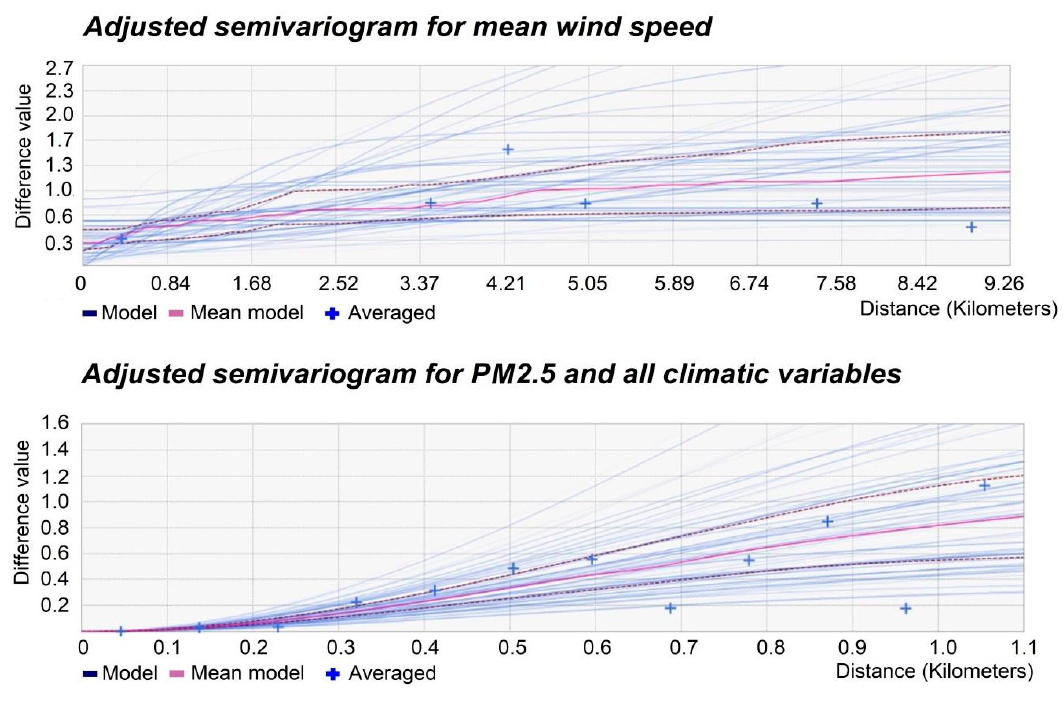
Figure 4. Adjusted semivariograms for PM 2.5 and mean wind speed .